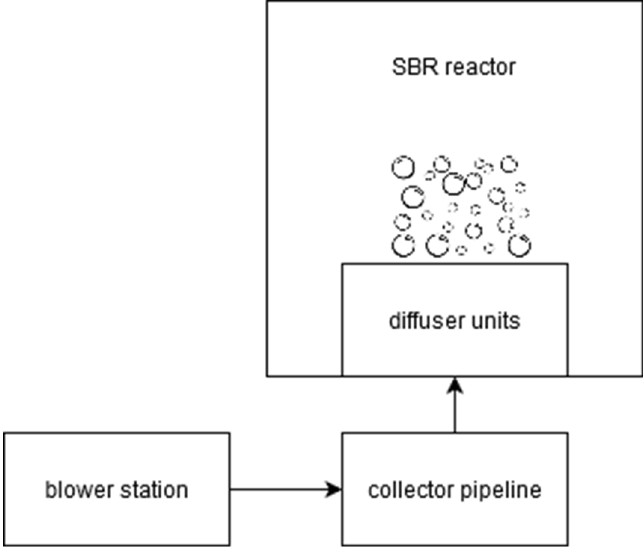
Figure 2. Schematic diagram of the aeration system.